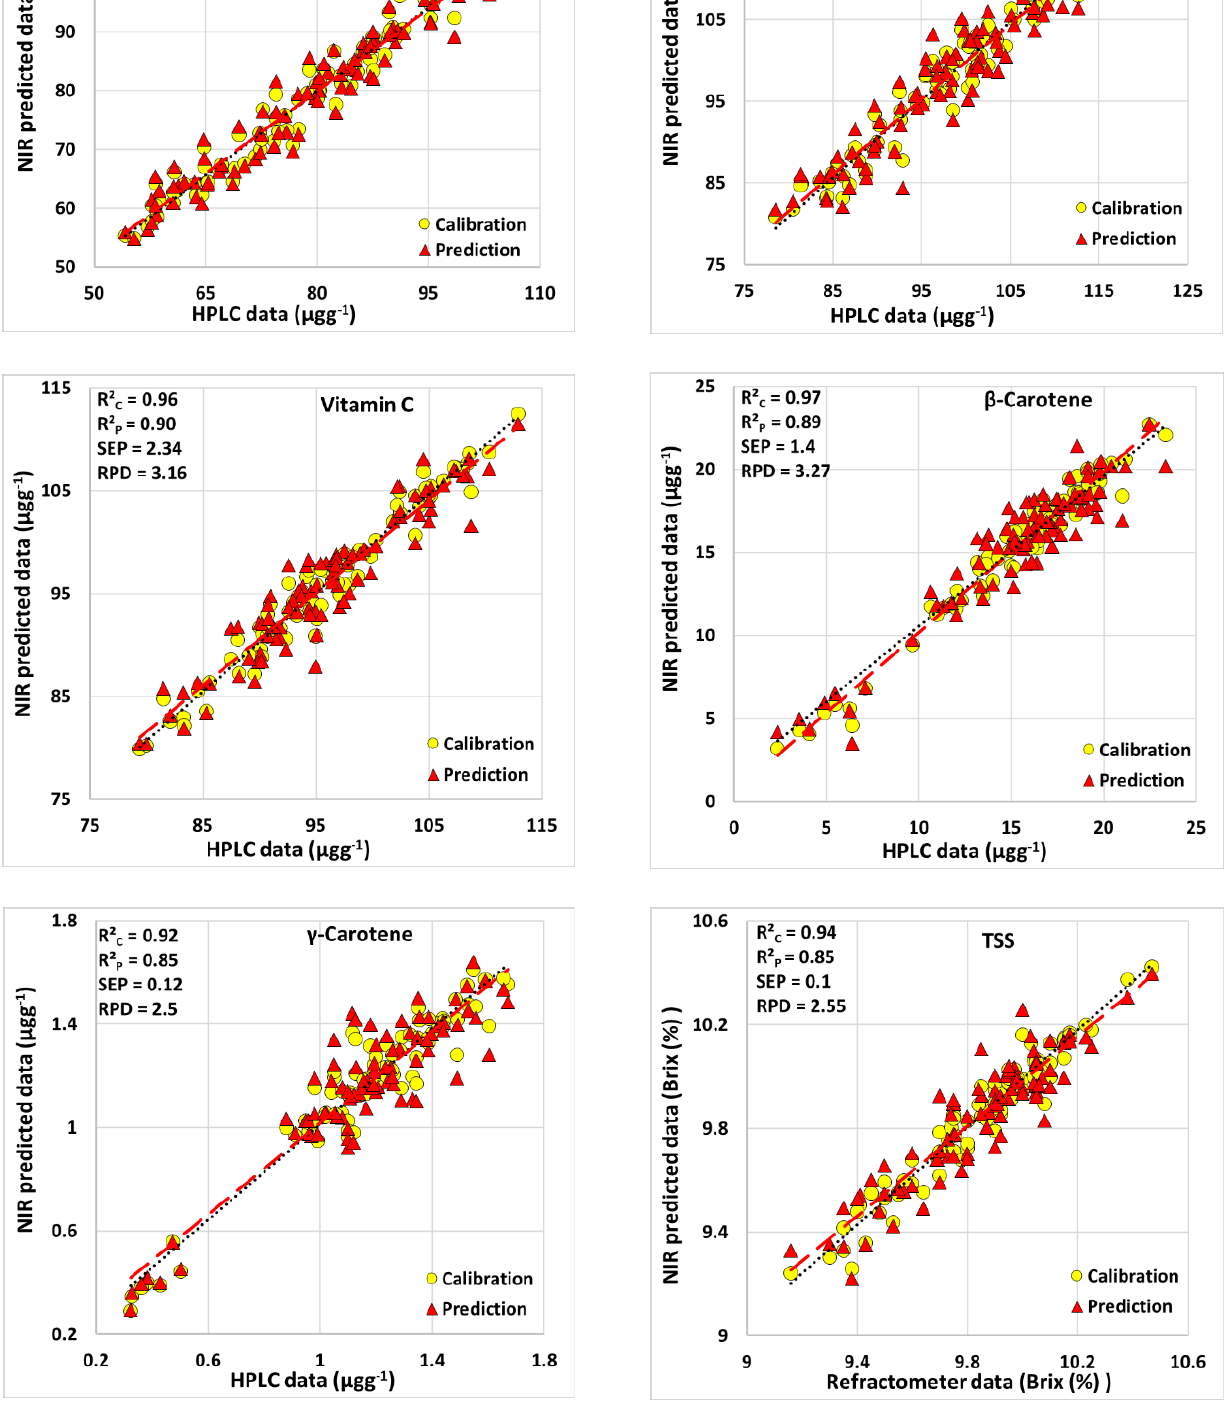
Figure 5. Demonstrates the accuracy of calibration and prediction models for lycopene, total carotenoids, vitamin C, β -carotene, γ -content, and TSS of watermelon samples. These results are higher than those obtained by [73] measuring vitamin C in apples within the wavelength range from 400–2500 nm and obtained a good prediction model for vitamin C by value 0.80 with SEP 4.9 mg100 g −1 , as well as [24] obtained predictive coefficients for ascorbic acid and β -carotene of 0.82 (SEP = 504.27 µgg −1 ), and 0.91 (SEP =